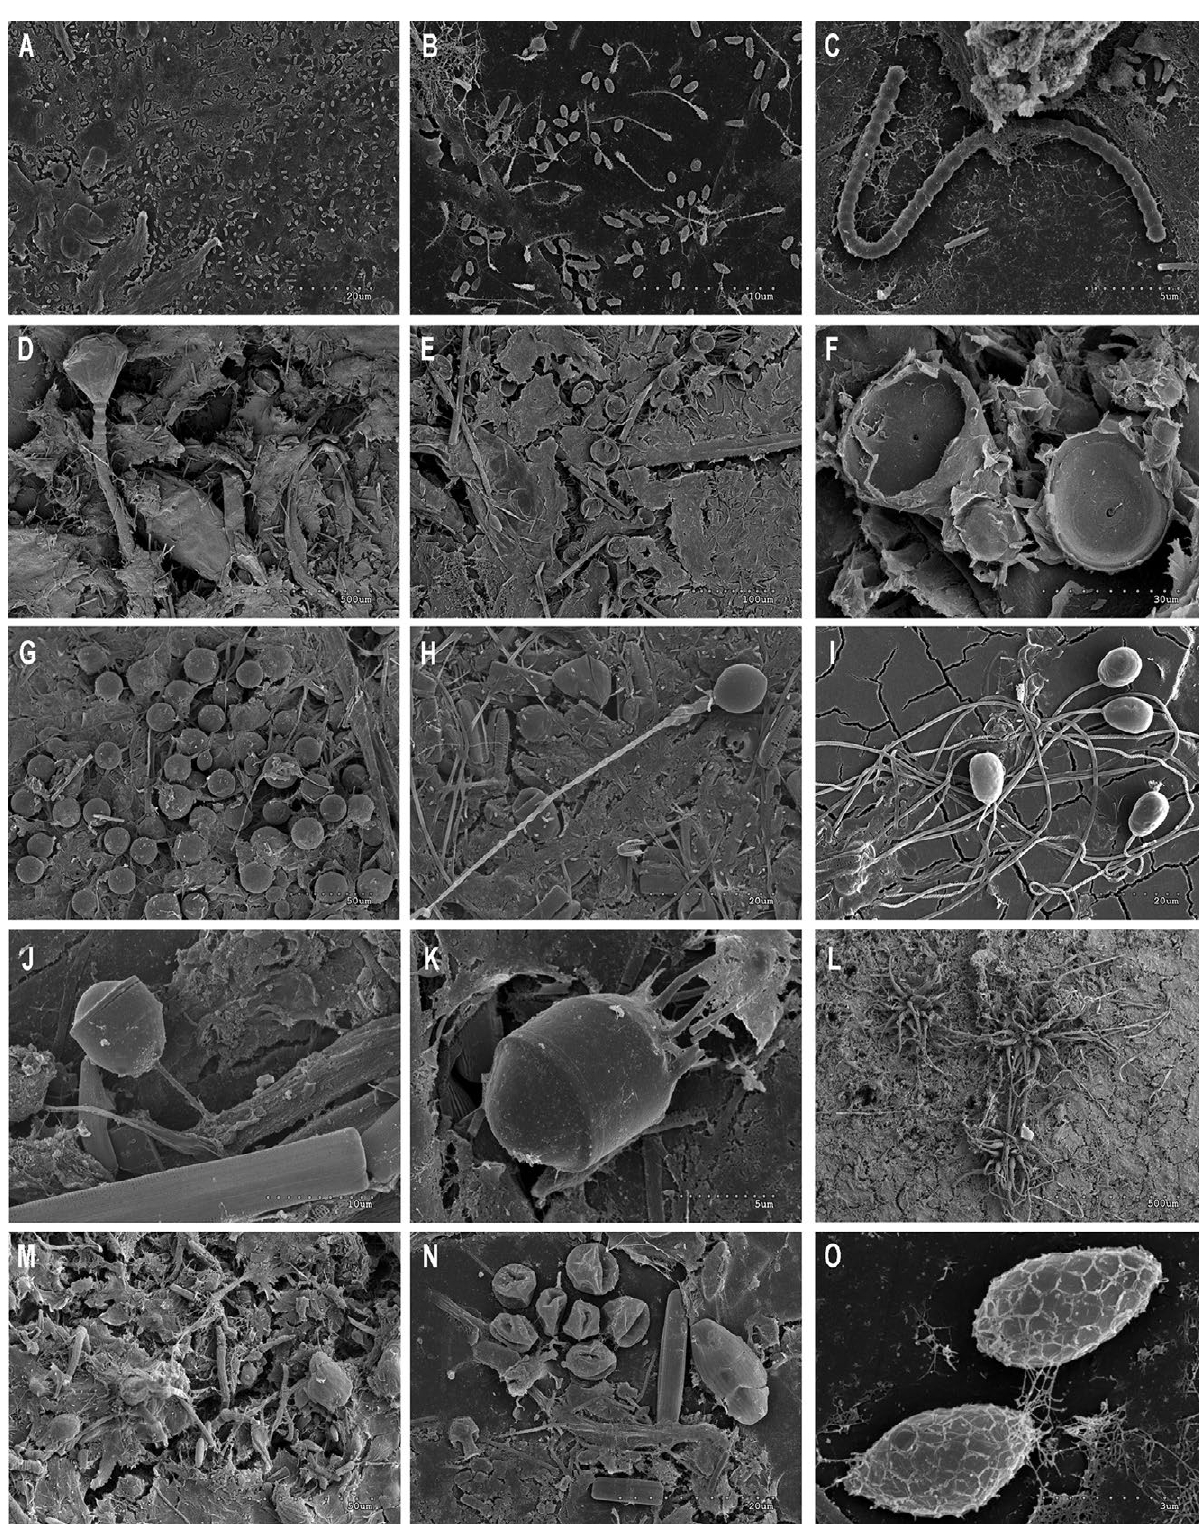
Fig. 5. – Organisms on pelagic plastics. A-B, bacteria on biofilms; C, cyanobacteria; D, E, F, different species of hydrozoans. G, H, I, nemato- cysts. J, K, resting spores; L, fungi; M, general image of biofilms with bacteria, fungi, diatoms and unidentified organisms; N, O, unidentified